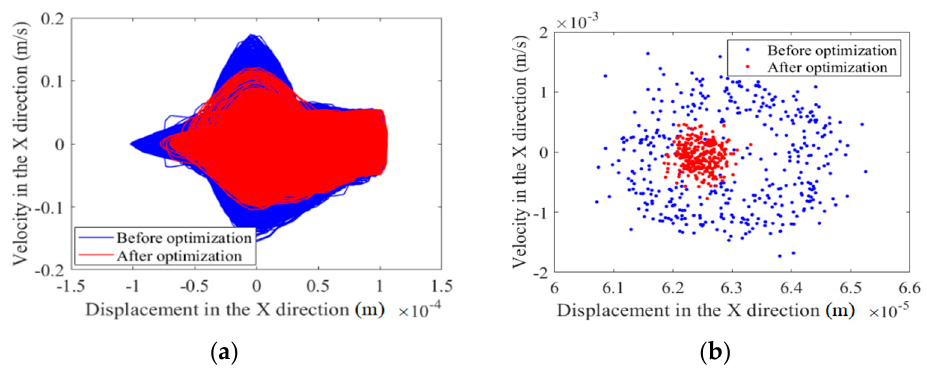
Figure 7. Nonlinear characteristics of joint A in the X direction. ( a ) Phase map. ( b ) Poincaré map.